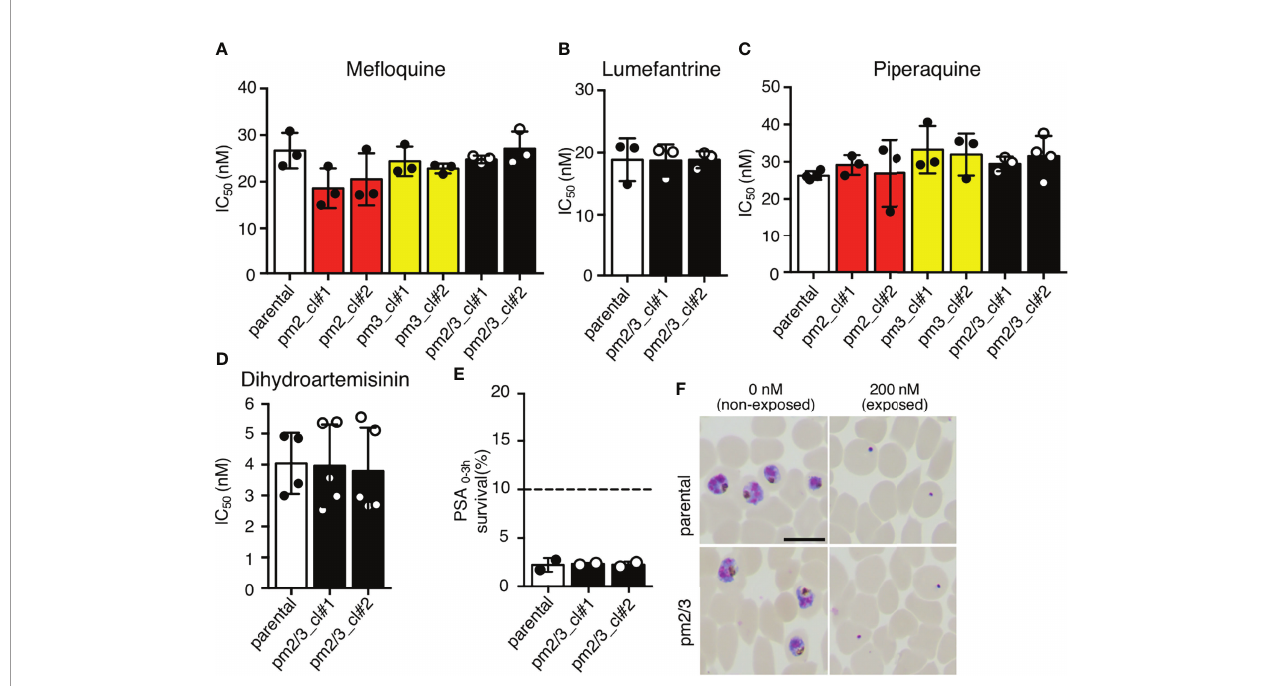
FIGURE 4 | The effect of an additional copy of pm2 and pm3 on drug sensitivity. (A – D) IC 50 values were determined for the antimalarial drugs me fl oquine, lumefantrine, piperaquine, and dihydroartemisinin with transgenic parasites harboring an additional copy of pm2 and/or pm3 (pm2_cl#1, pm2_cl#2, pm3_cl#1, pm3_cl#2, pm2/3_cl#1, and pm2/3_cl#2) versus the pfcas9 parental strain (parental). None of the IC 50 values for these transgenic parasites were signi fi cant versus the parental strain. IC 50 values ( Table 2 ) were calculated three to fi ve times. (E, F) In vitro piperaquine survival assays (PSA 0 – 3 h ) were performed for the pfcas9-pm2/ 3 and the parental strain. (E) Survival rates were determined as a percentage of the parasitemia obtained with treated versus drug-off and were not signi fi cant comparing transgenic parasites and parental. The dashed line represents the 10% survival rate cutoff that distinguishes piperaquine-resistant ( ≥ 10%) from piperaquine-sensitive (<10%) parasites in PSAs. (F) Thin blood smears stained with Giemsa reagent were prepared 24 h post-drug withdrawal. pfcas9-pm2/3 was killed by piperaquine treatment, as was the parental strain. N, n = 2 ( Table 2 ). A scale bar indicates 10 µm. Signi fi cance was determined using Student ’ s